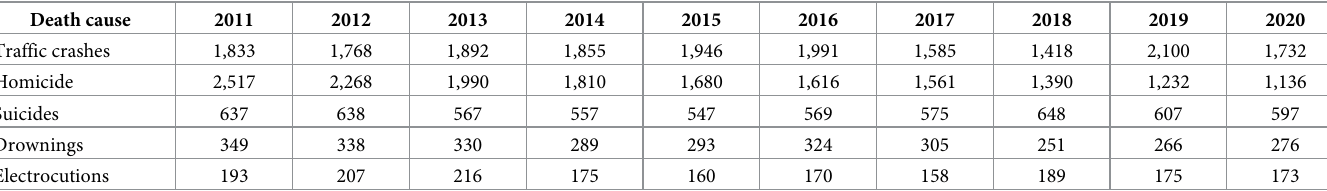
Table 2. Number of deaths caused by an external source registered in the place of the crash (objective data).